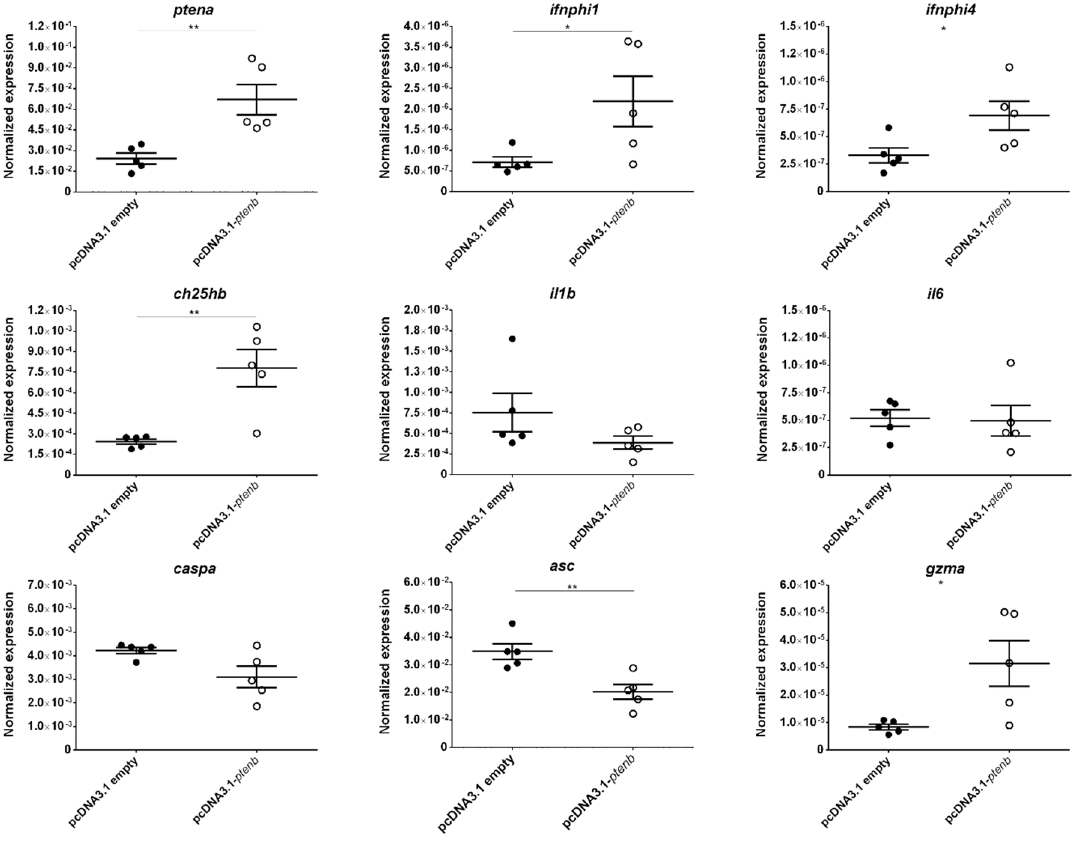
Figure 10. Effect of gene rescue on the expression of dysregulated genes in ptenb mutant zebrafish larvae. The expression of the different genes was normalized to the expression of the 18S ribosomal RNA gene. The graphs represent the means ± SEMs of 5 biological replicates. Statistically significant differences are displayed as ** (0.001 < p < 0.01) or * (0.01 < p < 0.05).